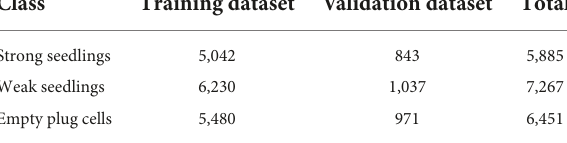
TABLE 1 The sample size of the training set and validation